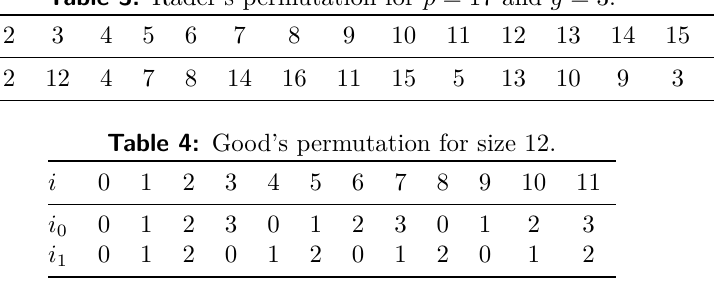
Table 3: Rader’s permutation for p = 17 and g = 3.